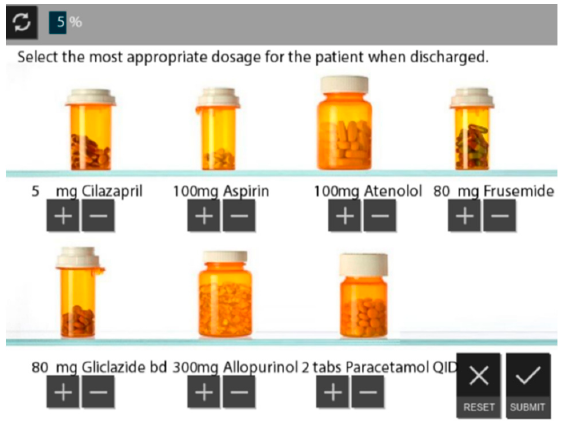
Figure 2. Part II of R2P: medication chart.